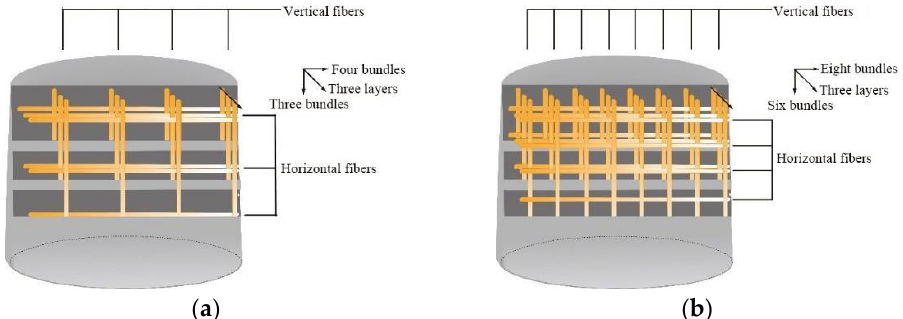
Figure 3. Fiber mesh layout; ( a ) Grid size 40 mm × 40 mm; ( b ) Grid size 20 mm × 20 mm.